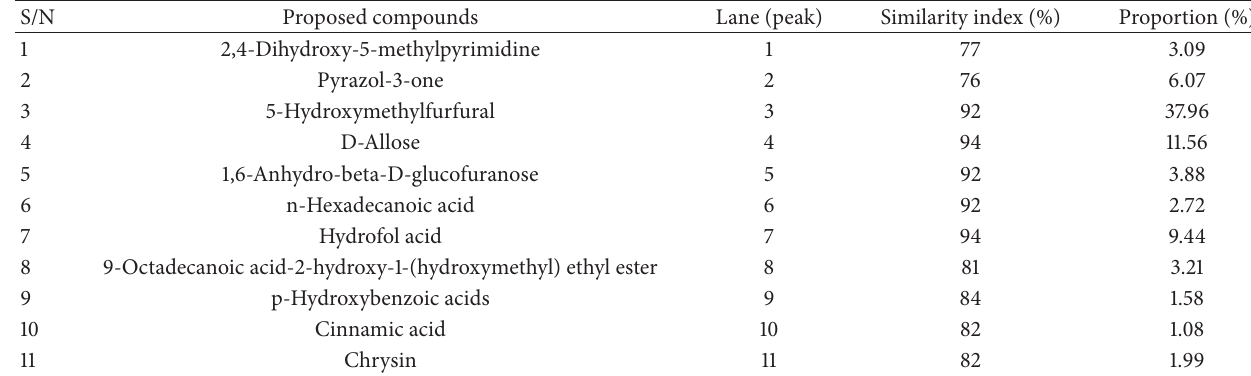
Table 4: The result of GC-MS analysis of Acacia